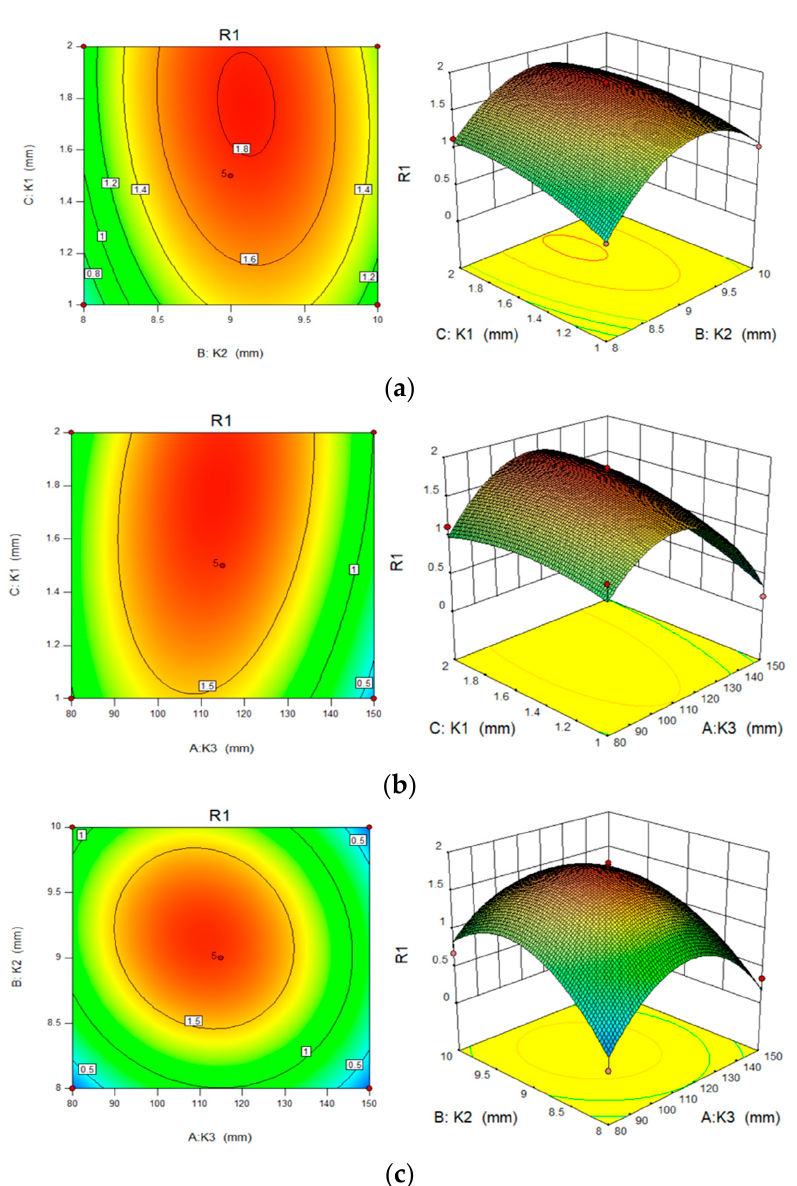
Figure 16. Three-factor interaction curve and contour map. ( a ) Interaction of blade thickness K1 and turbine hub radius K2. ( b ) Interaction of blade thickness K1 and front guide grid K3. ( c ) The interaction between the turbine hub radius K2 and the front spoiler K3.